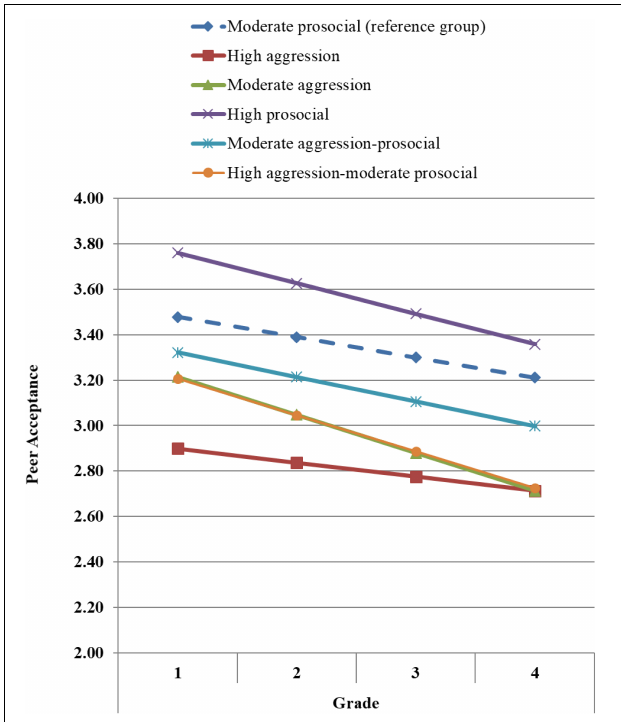
FIGURE 2 | Children’s predicted peer acceptance trajectories by co-occurring aggression and prosocial trajectory classes.